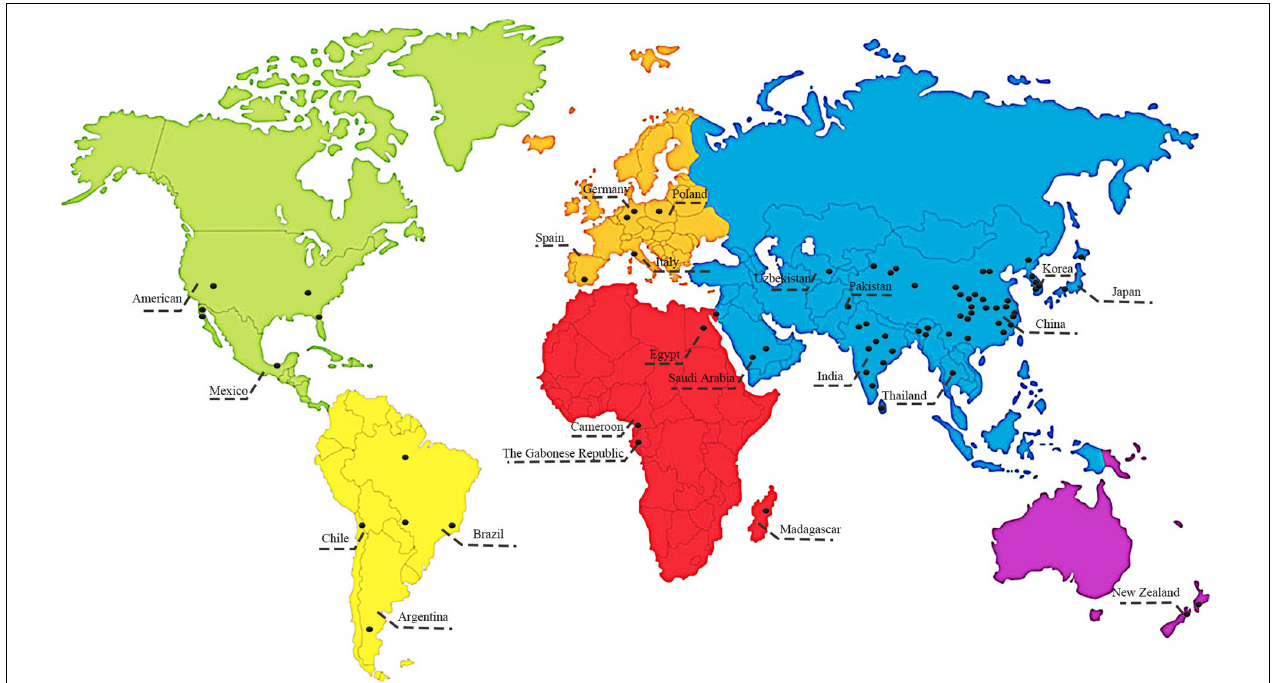
FIGURE 2 | Geographical distribution of medicinal plants and related endophytic bacteria, considered in the